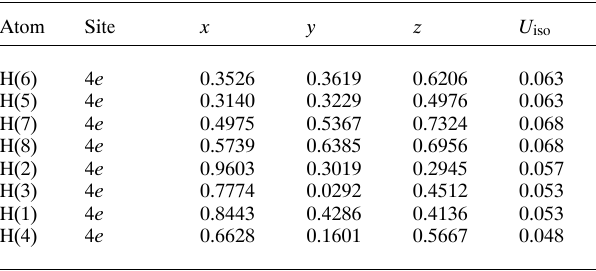
Table 2. A tomic coordin a tes a nd displ a cement p a r a meters (in Å 2 )